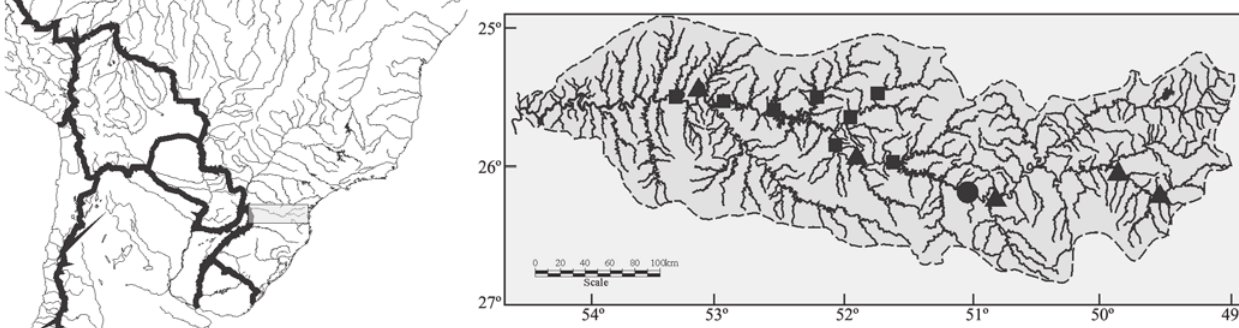
Fig. 6. Map of Southern Brazil and adjoining countries showing the geographic distribution of Astyanax gymnodontus in the rio Iguaçu basin (rectangle in focus). Bold lines are national borders. Squares = examined material; triangles = distribution showed by Severi & Cordeiro (1994); and dot = type-locality of Psalidodon gymnodontus . Some symbols represent more than one lot or